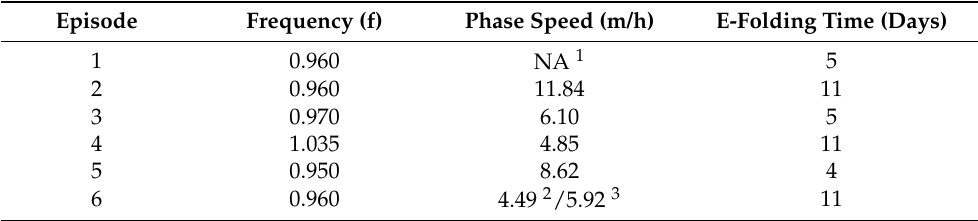
Table 1. Depth-mean frequencies, vertical phase speed, and e-folding time of each episode.